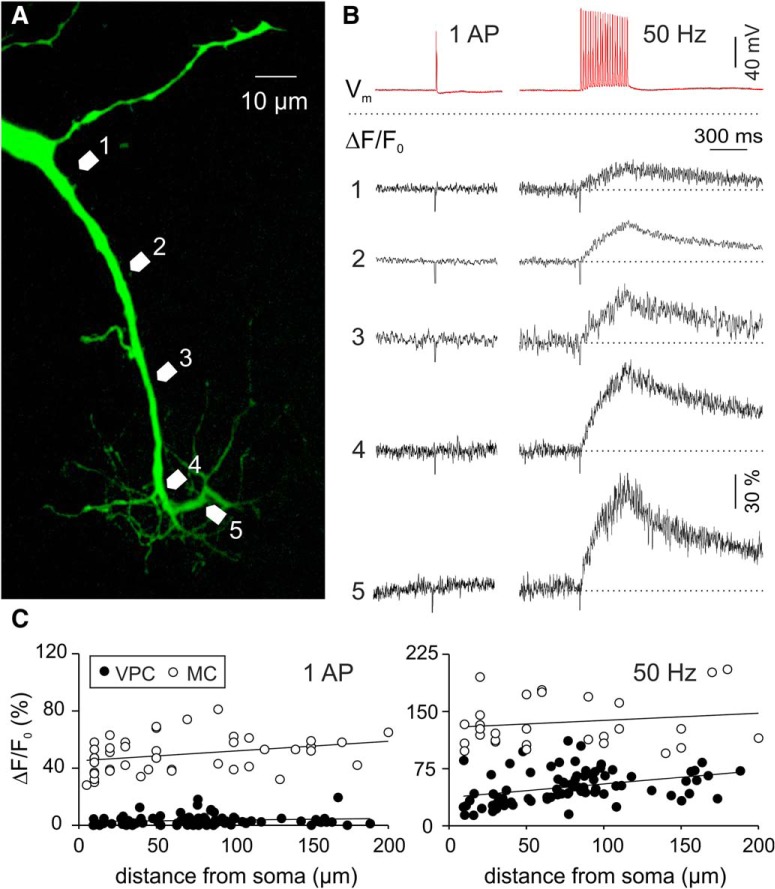
A, Two-photon scan of a representative VPC filled with the Ca2+-sensitive dye OGB-1. Numbered arrows in the scan correspond to the locations of the numbered averaged (n = 4) ΔF/F transients shown in B, in response to a single somatically-evoked AP (1000 pA, 1 ms) or a 50 Hz train (20 APs, 50 Hz, 400 ms). C, ΔF/F of apical dendrites and tufts versus distance from soma in VPCs (N = 11) and MCs (N = 13). MC, mitral cell; VPC, vasopressin cell.